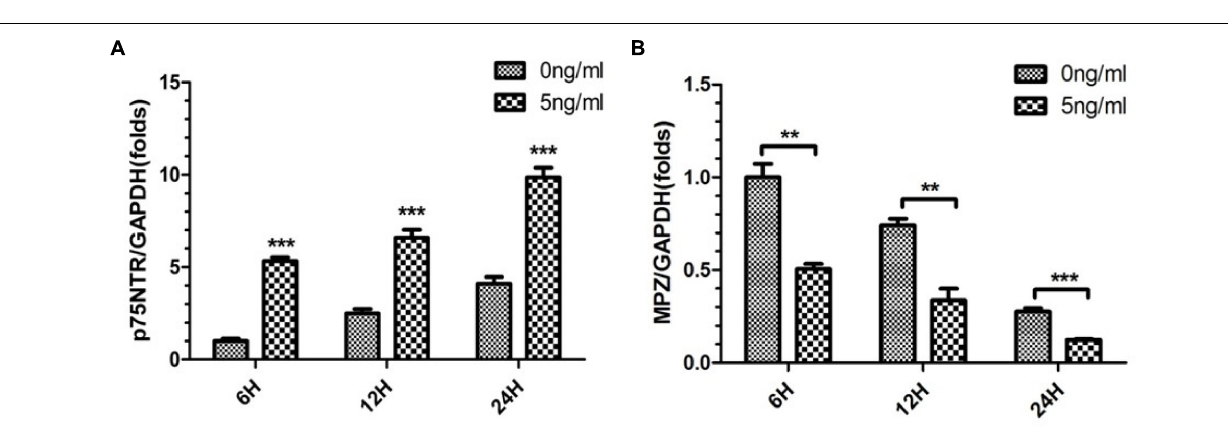
FIGURE 3 | Expression of p75NTR and MPZ mRNA in the in vitro WD model. qPCR was used to quantitatively analyze expression of p75NTR (A) and MPZ mRNAs (B) with or without 5 ng/ml IL-1 β at 6, 12, and 24 h. Results are means ± SE ( n = 3 per group) from independent experiments. ∗∗ p < 0.01, ∗∗∗ p <